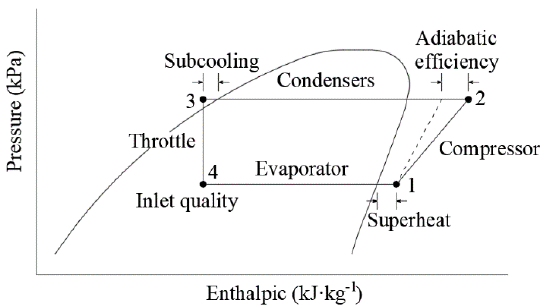
Figure 3. Pressure-enthalpy diagram of a refrigerant cycle in a heat pump.